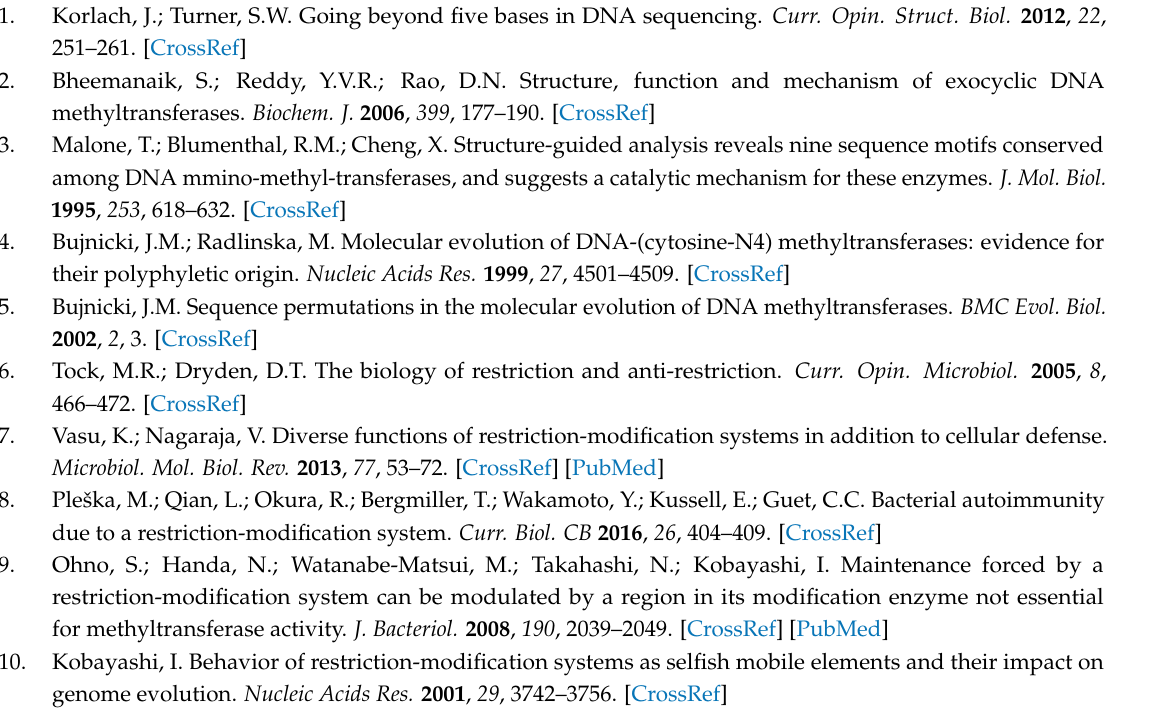
Figure S1: Workflow of RMS-candidate gene search strategy, Figure S2: Plot of alignment distance as a function of presence–absence distance, Figure S3: PCoA plot of the distances between the RMS presence–absence profiles of the 217 analyzed Halobacterial genomes, Figure S4: Maximum-likelihood phylogeny of cHG presence–absence matrix, Figure S5: Bootstrap support values of the presence–absence phylogeny mapped onto the ribosomal protein reference tree, Table S1: Basic statistics for Halobacteriaceae complete and draft genomes, Table S2: Gene Ontology (GO) terms for each collapsed homologous group, Table S3: Distribution of orphan methylases cHGs U and W and frequency of their putative recognition motifs in completely sequenced halobacterial